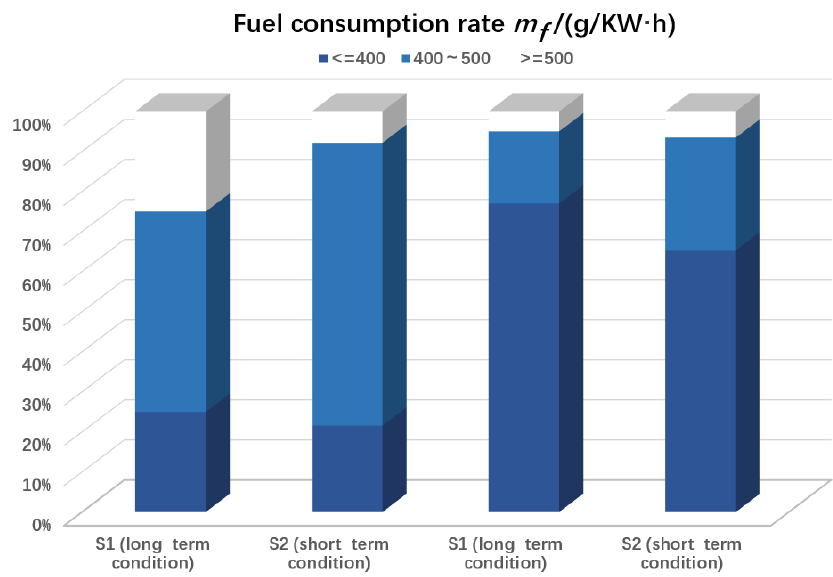
Figure 17. Distribution statistics of operating points.